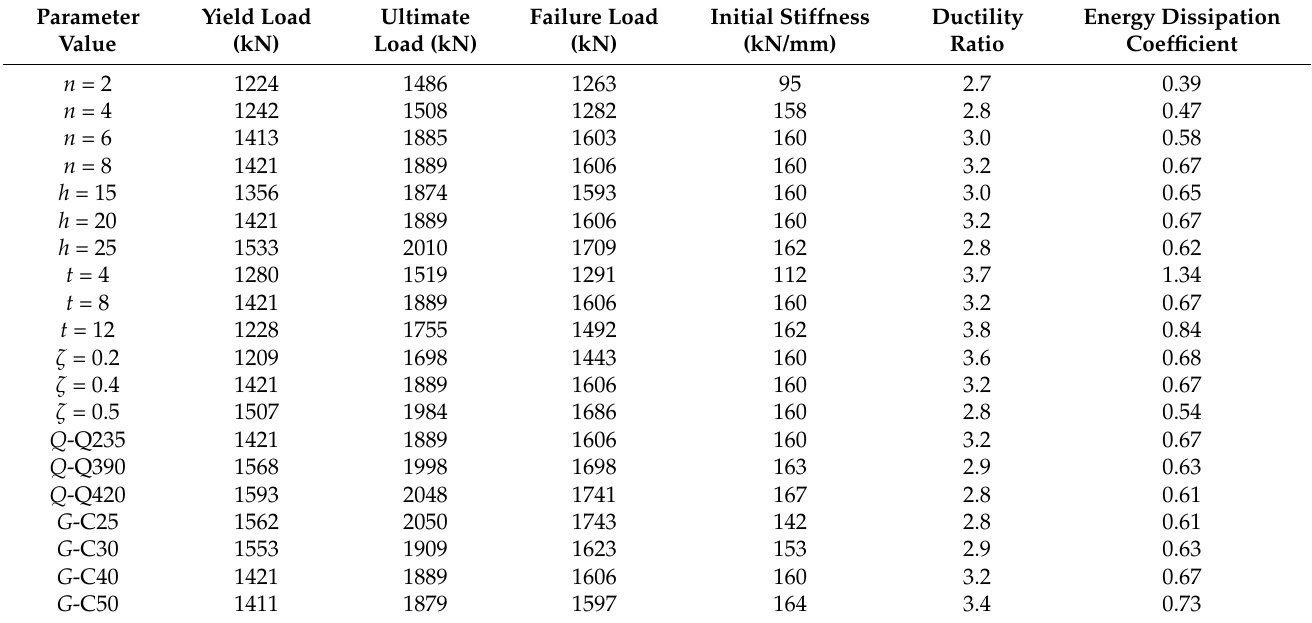
Table 9. Values of characteristic indexes of load–displacement skeleton curves for each model.